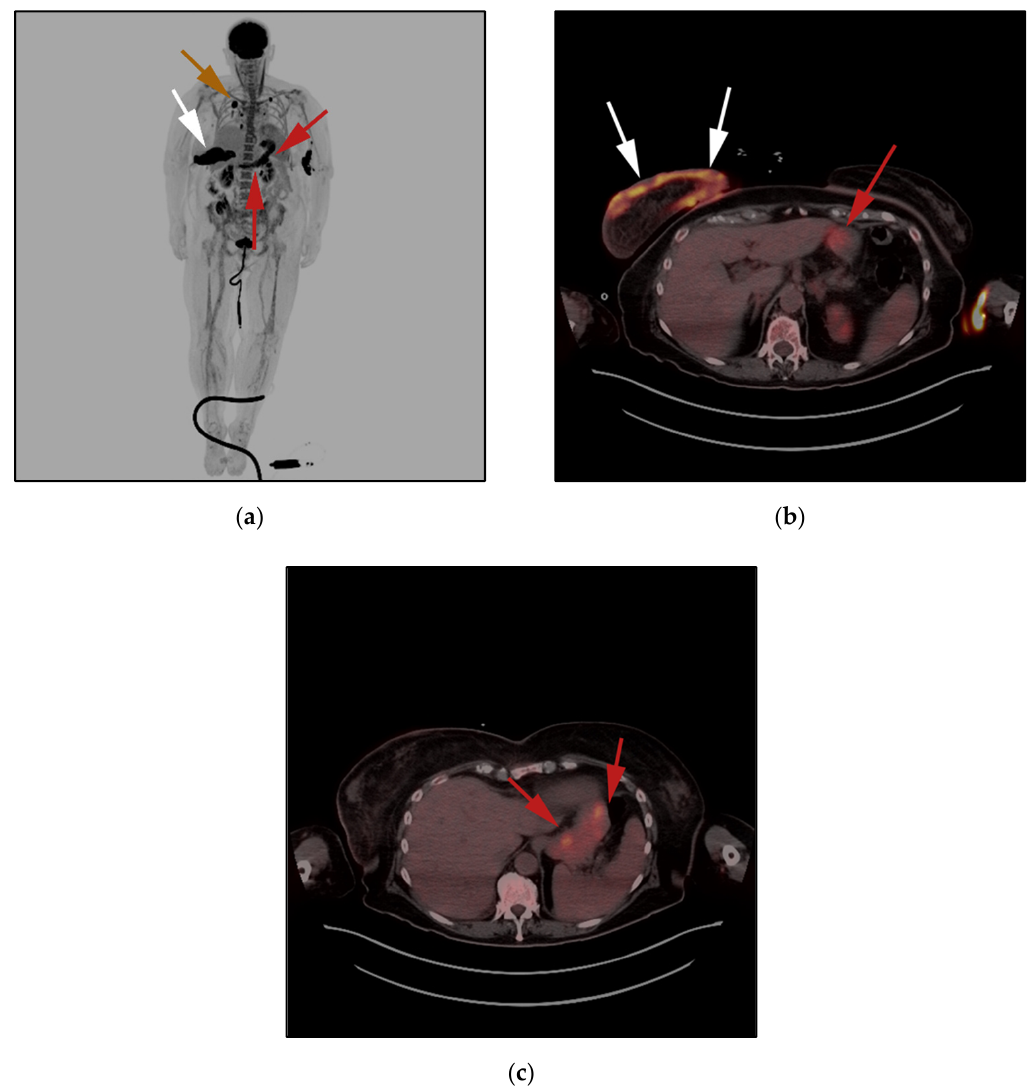
Figure 6. 50-year-old-female with known diagnosis of PTCL-NOS. ( a ) F-18 FDG PET/CT maximal intensity projection (MIP) image demonstrates increased activity localized to the anterior chest wall (white arrow), curvilinear activity seen within the epigastric region (red arrows) as well as rounded activity within the right upper lung (brown arrow). ( b , c ) F-18 FDG PET/CT axial images confirm the location of the lesion within the skin of the right breast (white arrow) as well as stomach (red arrows).